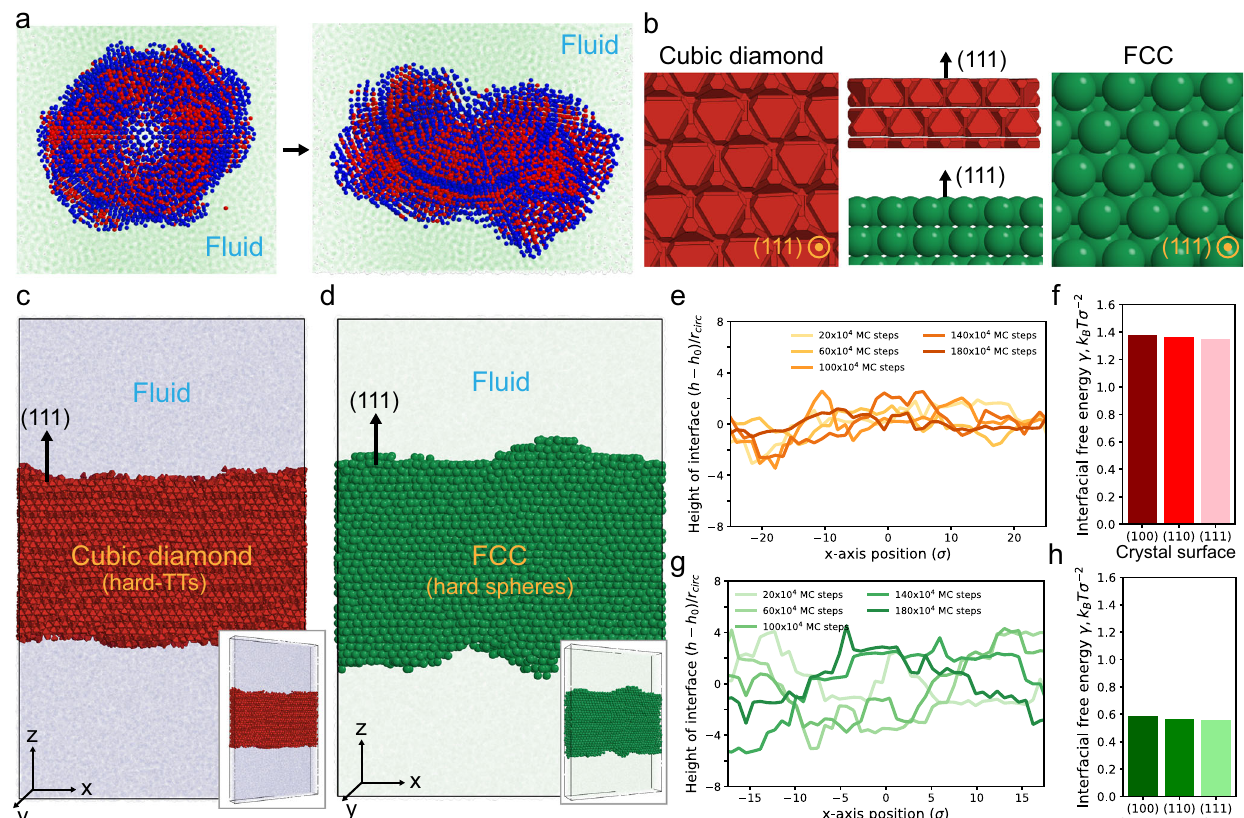
Fig.4|Fluid-solidinterfacialenergycalculation.a Icosahedraltwinnedcrystalof FCCofhardspheresquicklydestabilizesin fl uid(<10 6 MCsteps). b (111)surfacesof acubicdiamondcrystalofhardTTs(left)andanFCCcrystalofhardspheres(right), and their side views (middle).Simulation setup of the capillary fl uctuation method for calculating the fl uid-solid interfacial stiffness e γ of ( c ) cubic diamond and ( d )